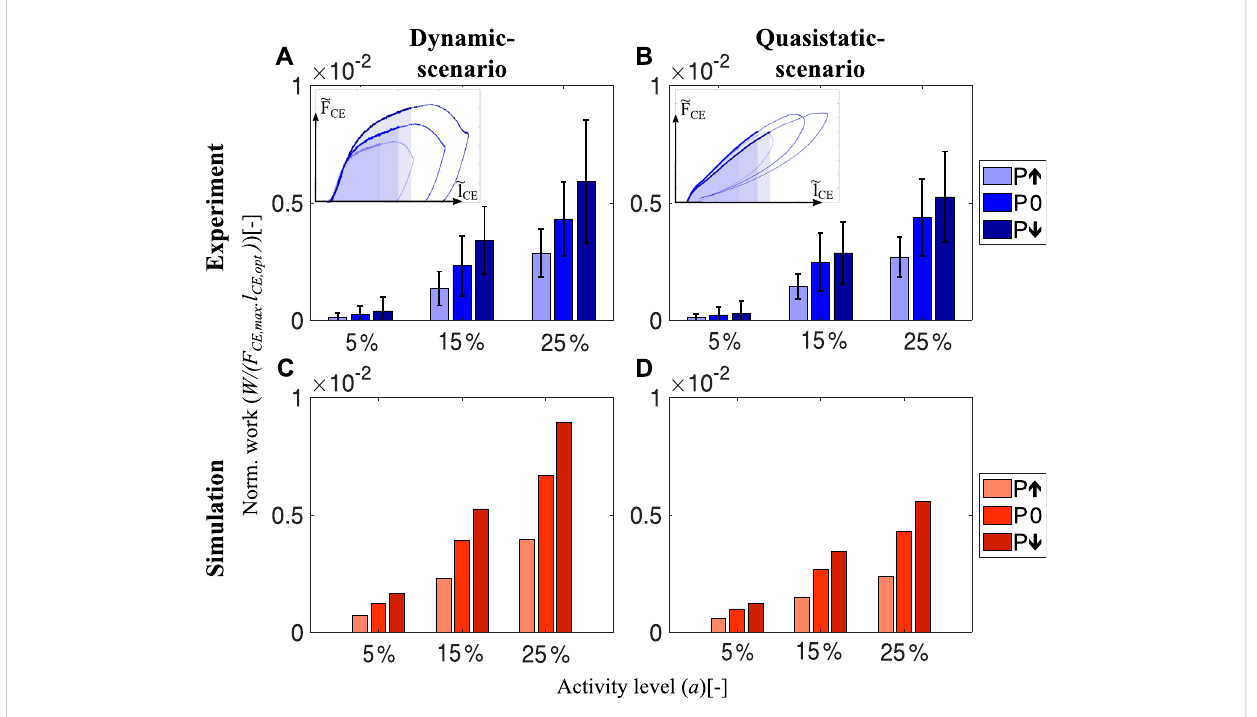
FIGURE 4 Theamountofpre fl exworkdonebyskinned fi bersandtheisolatedcontractileelementoftheHill-typemusclemodelforallperturbationstatesand activitylevels.Inthedynamic-scenarioanalysis,workdoneduringthepre fl exphasewascalculatedastheareaundertheforcecurve.Shadedareasinthe insets (A) and (B) indicate changing perturbation levels. In the quasistatic-scenario analysis, the area till the lengthening reached at the end of the pre fl ex phase was analyzed for each perturbation level. Bars in (A,B) and (C,D) indicate the work done by skinned muscle fi bers and the isolated contractile elementatdynamic-scenarioandquasistatic-scenario,respectively.Wecalculatedandindicatetheareaofthenormalizedworksloops(Figure3).Hence, there is no need to match the parameters of the hopping simulation to experimental muscle size.